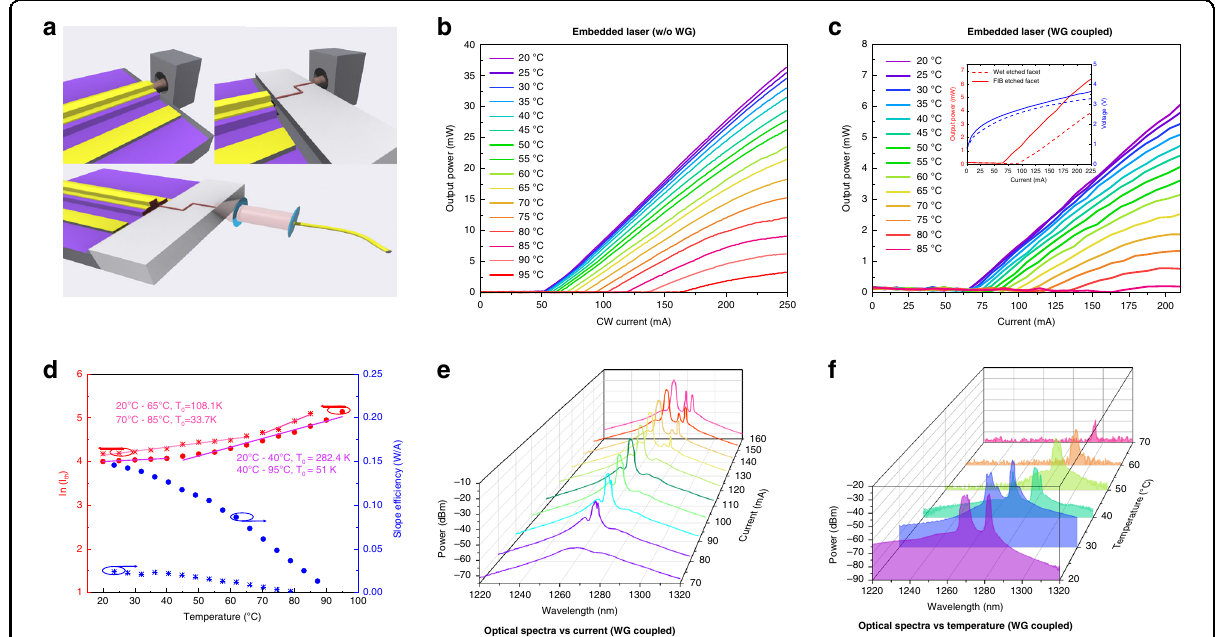
Fig. 5 Continuous-wave characterizations of embedded InAs QD laser on SOI with and without coupling into silicon waveguide. a Schematics of L-I and optical spectral measurements; top left: L-I measurements of double-side cleaved III-V laser inside SOI trench; top right: L-I measurements of embedded InAs QD laser from silicon waveguide output; bottom: optical spectral measurements from the silicon waveguide. b Continuous-wave temperature-dependent L-I measurements of double-side cleaved III-V laser inside SOI trench as reference laser. c Continuous- wave temperature-dependent L-I measurements of integrated laser with one cleaved facet and FIB etched for the other; inset: room-temperature L-I comparison between single-side wet etched facet and FIB etched facet. d Plots of natural logarithm of threshold current and slope ef fi ciency versus varied operating temperatures; characteristic temperature (T o ) are fi tted for double-side cleaved embedded laser (red dots) in temperature ranges from 20 to 40 °C and 45 to 95 °C, respectively; characteristic temperature (T o ) are fi tted for embedded laser with integrated silicon WG (red stars) in temperature ranges from 20 to 65 °C and 70 to 85 °C, respectively. e Optical spectral analysis of integrated laser versus increased injection current. f Optical spectral analysis of integrated laser versus temperature